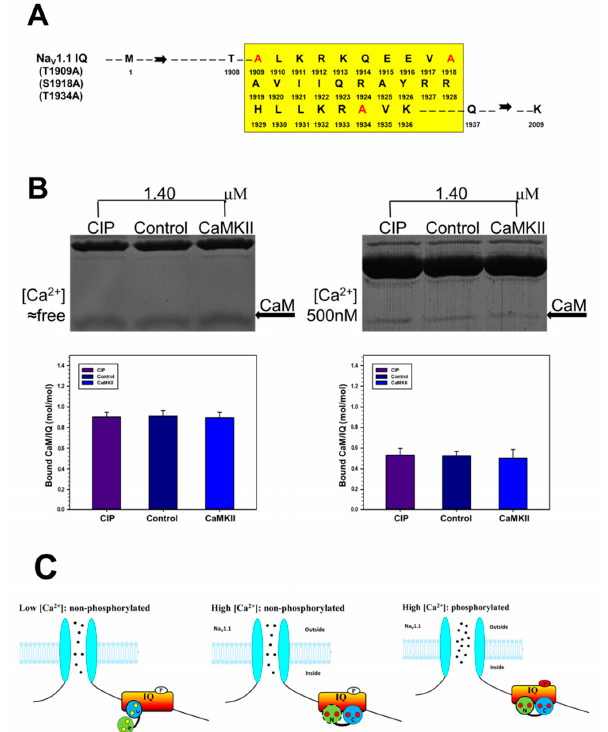
Figure 7. Neutralized CaMKII-mediated phosphorylation sites on Na V 1.1 IQ domain. ( A ) Schematic illustrations of mutated Na V 1.1 IQ domain with three potential CaMKII-mediated phosphorylation sites, T1909A, S1918A, and T1934A. The mutated amino acids are presented by red letter code; ( B ) GST pull-down assay for the binding of CaM to mutated Na V 1.1 IQ. GST-fusion IQ was incubated with fixed concentration of CaM (1.4 μ m) at fixed [Ca 2+ ] of ≈ free and 500 nM. Protein bands were stained by Coomassie Brilliant Blue. CaM protein bands are pointed out by arrows. ( B ) Bound CaM are plotted against total [CaM] on a molar ratio basis (CaM/IQ) with mean ± S.E. ( n = 4 for CaM); and ( C ) Schematic illustrations of a hypothetical model for the modulation of Ca 2+ /CaM/CaMKII on Na V 1.1. At low [Ca 2+ ], a nonphosphorylated state of IQ domain, C-lobe is the predominant domain for apoCaM binding to IQ domain, and the binding of apoCaM to Na V 1.1 IQ is not affected by CaMKII. At high [Ca 2+ ], but a nonphosphorylated state of IQ domain, N-lobe becomes the predominant domain since some of CaM binds with Ca 2+ . Phosphorylation of IQ by CaMKII modulates the binding of Ca 2+ /CaM to the channel. Meanwhile, channel activity is maintained to the basal level. At high [Ca 2+ ],